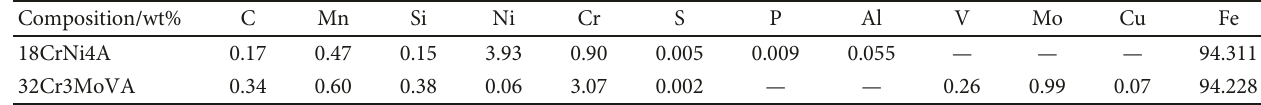
Table 1: Chemical composition of alloy steels 18CrNi4A and 32Cr3MoVA.